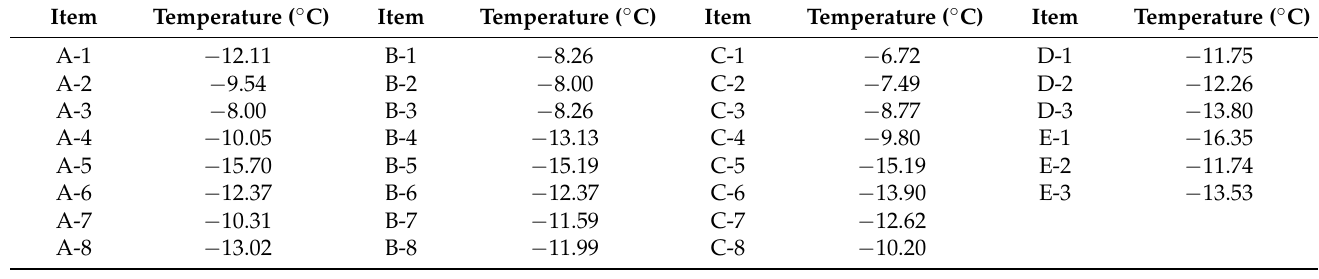
Table A2. Measured skin surface temperatures in different sections on outer shell skin surfaces of reduced-scale cabin mockup.